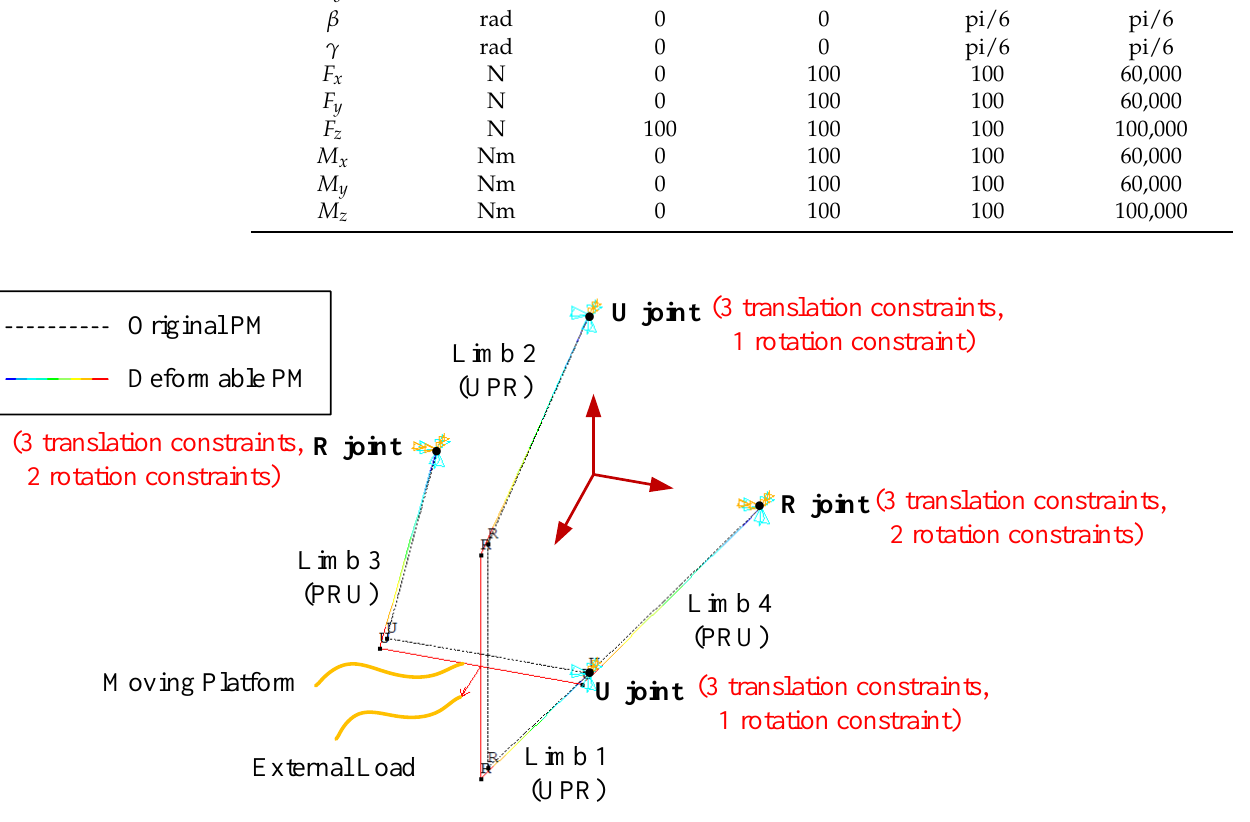
Figure 6. Boundary conditions of the redundantly actuated 2UPR – 2PRU PM in ANSYS software.